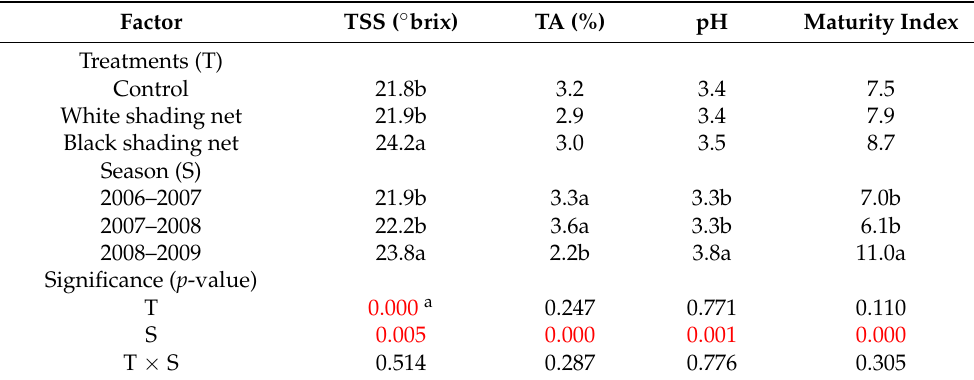
Table 3. Analysis of variance for berry physicochemical variables by shading net treatments